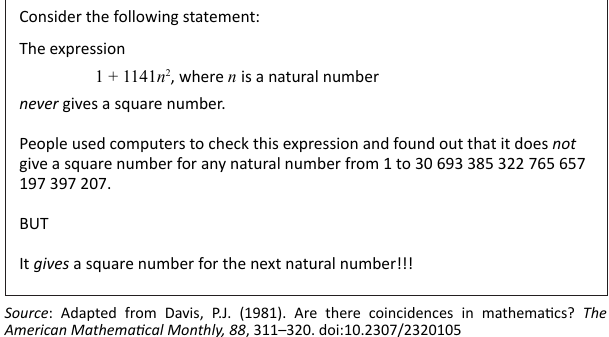
FIGURE 3: The Monstrous Counter-example